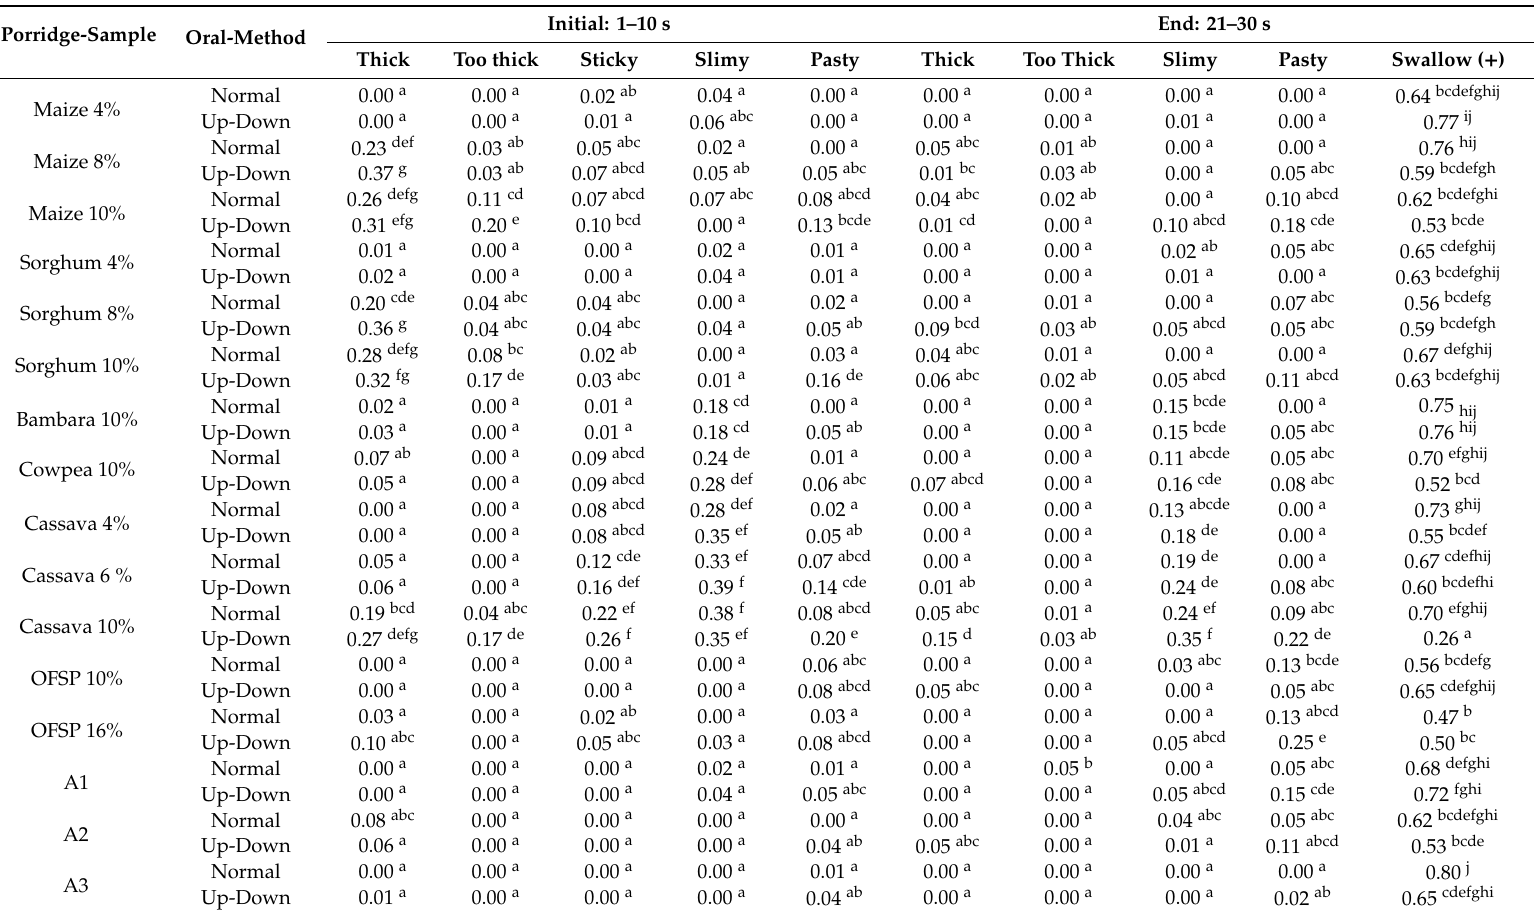
Table 4. E ff ect of complimentary porridge (CP) type and oral processing (OP) method on citation proportions for texture attributes during the initial (1–10 s) and ending (21–30 s) phases of evaluation by the trained Temporal Check-All-That-Apply (TCATA) panel ( n = 10). Main e ff ects ANOVA followed by Fisher’s Least Significant Di ff erence (LSD) test for pairwise